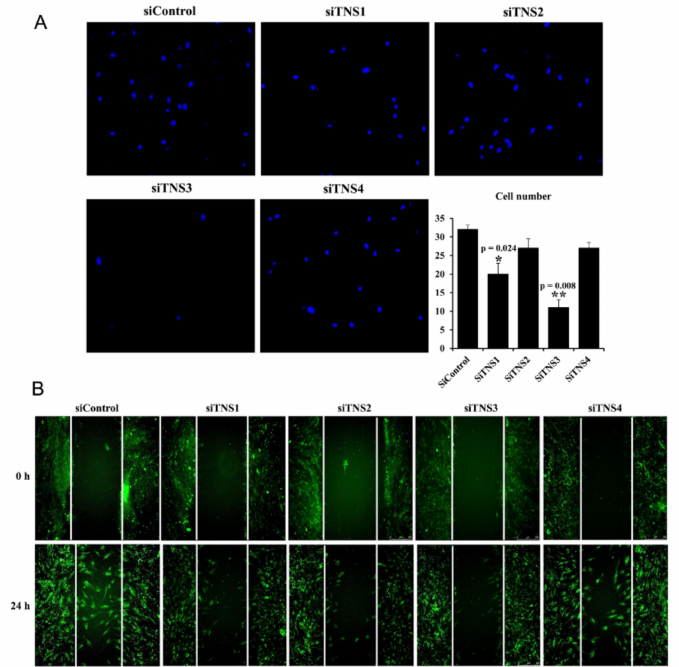
Figure 3. Tensin family is involved in the migration of tonsil mesenchymal stem cells. Migration cell number was reduced after transfection with siTNSs in both transwell ( A ) and two-dimensional wound healing assay with fluorescence on actin ( B ). Notably, it was significantly decreased after siTNS1 and siTNS3 treatment. * p < 0.05 and ** p < 0.01, compared to siControl. n = 4. Columns and error bars represent mean ± standard